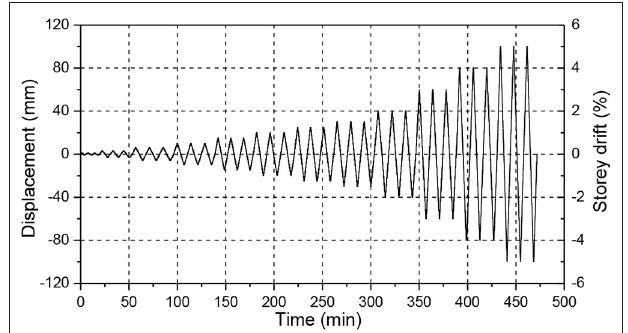
FIGURE 17 | Applied displacement history for semi-interlocking masonry (SIM).